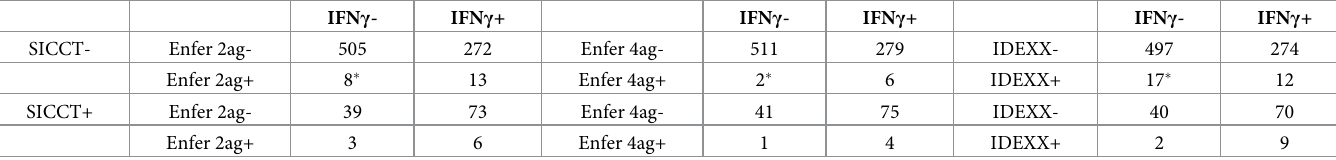
Table 5. Tabulation of the relationship between serological test results, gamma interferon (IFN γ ) status by skin test status.